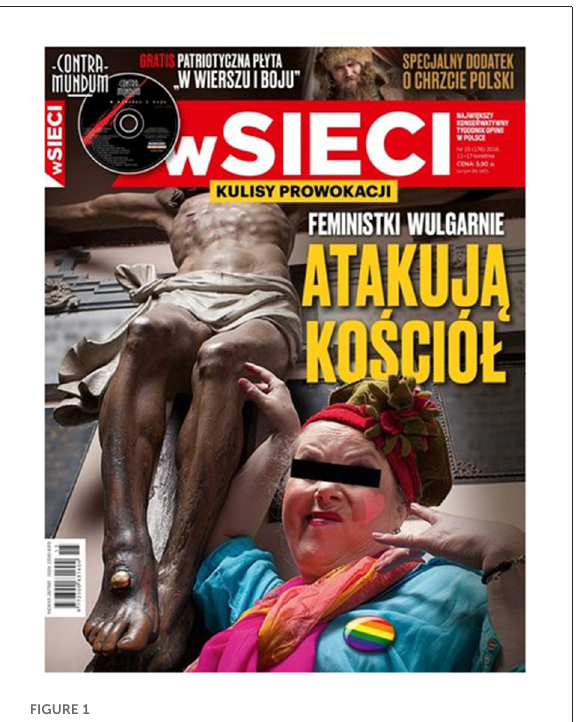
FIGURE1 The cover of Sieci , no.